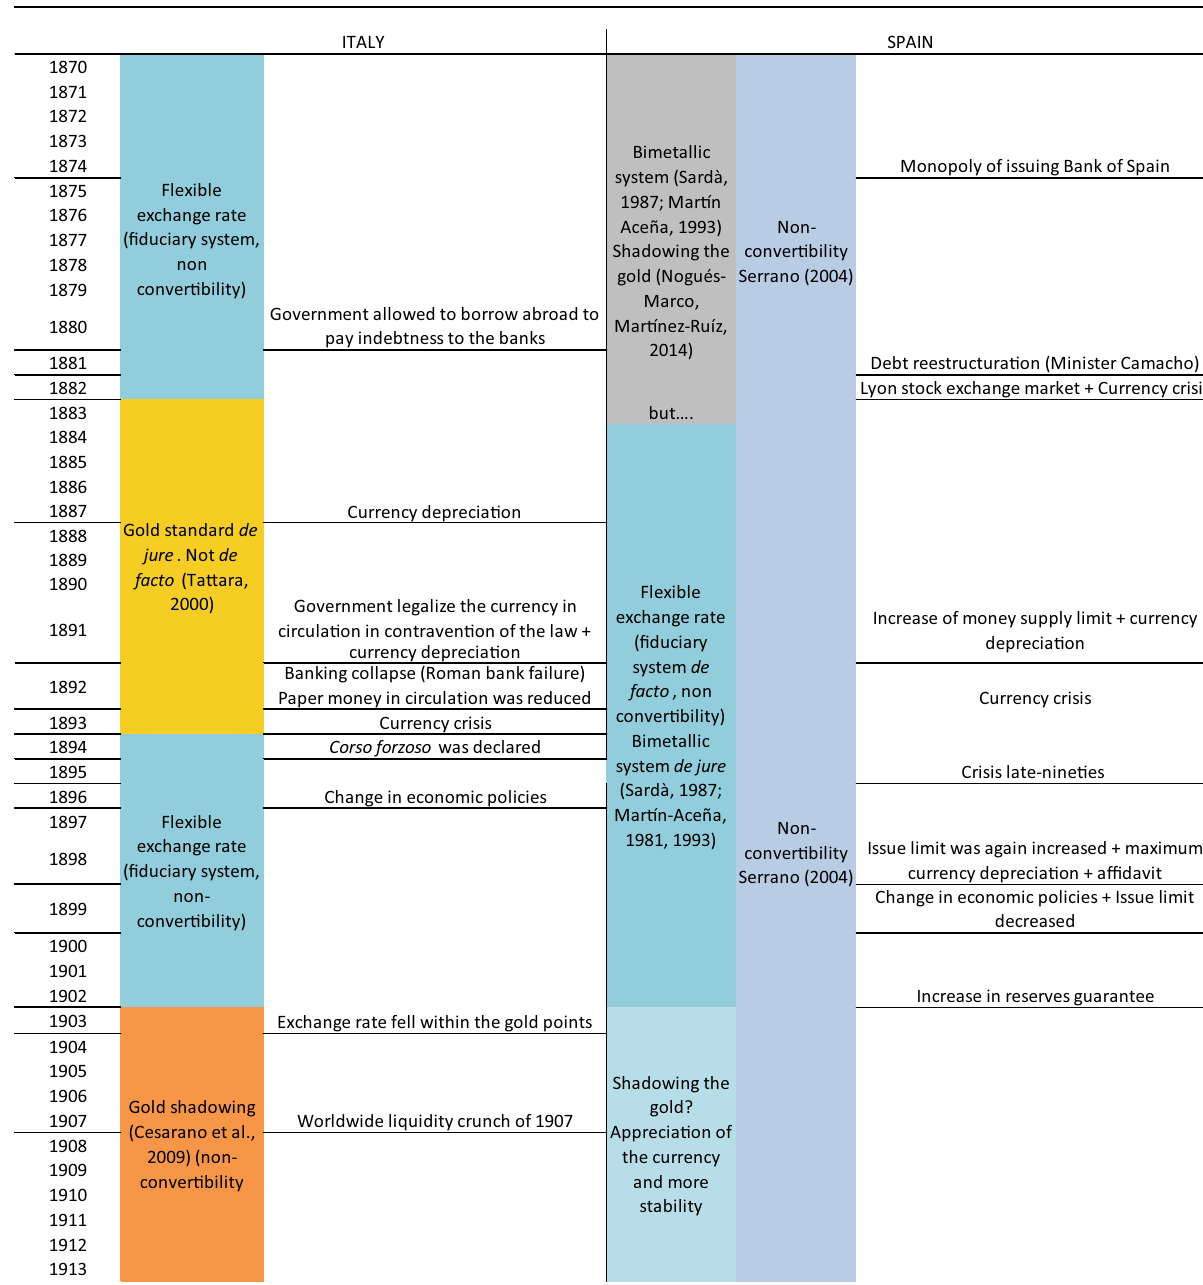
Table 1: Summary of di ff erent monetary systems adopted by Spain and